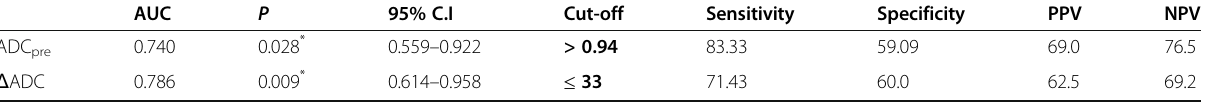
Table 4 Agreement (sensitivity, specificity) for ADCpre and Δ ADC to predict local failure cases AUC P 95% C.I Cut-off Sensitivity Specificity PPV NPV ADC pre 0.740 0.028 * 0.559 – 0.922 83.33 Δ ADC